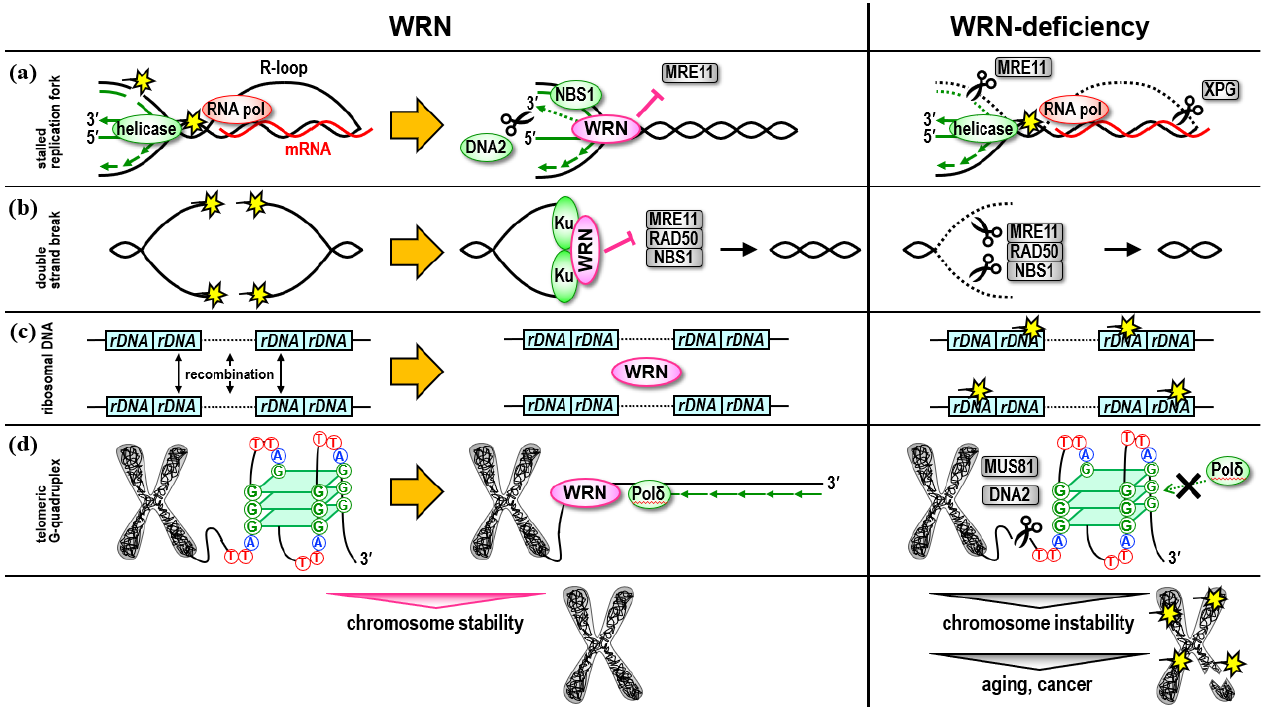
Figure 1. Roles of WRN helicase in DNA repair pathways. WRN helicase is involved in the mainte- nance of chromosome stability through actions in DNA replication, repair, and recombination via interaction with DNA repair factors, telomere-binding proteins, and other DNA metabolic factors. ( a ) At the reversal site of the nascent DNA strand generated by the arrested replication fork, WRN is thought to support replication fork reassembly. At the reversal site of collision of Pol II complexes with replication forks, the cells preferentially utilize the WRN function to restore transcription and DNA replication. If the WRN does not function, small-scale DNA strand degradation occurs around the replication fork caused by other DNA repair pathways, resulting in the deletion of genetic infor- mation and abnormal chromosome structure. ( b ) In DNA double-strand break repair, WRN binds to the DNA ends of the breaks together with the Ku dimer, inhibits the recruitment of the MRN complex, promotes non-homologous end-joining repair, and prevents repair involving deletion of genetic information due to end resection. ( c ) WRN is involved in maintaining a highly regular and uniform rDNA repeat structure in the human rDNA array, suppressing illegitimate DNA recombi- nation. ( d ) WRN helicase supports the synthesis of the nascent lagging strand by replicative DNA polymerase while resolving the quadruplex structure. In WS patient cells, when the replication of the nascent lagging telomere strand is stalled due to the formation of a quadruplex structure in the G-rich templates, MUS81 or DNA2 nuclease may act on the site to stimulate the resumption of replication, resulting in the shortening of the lagging telomere